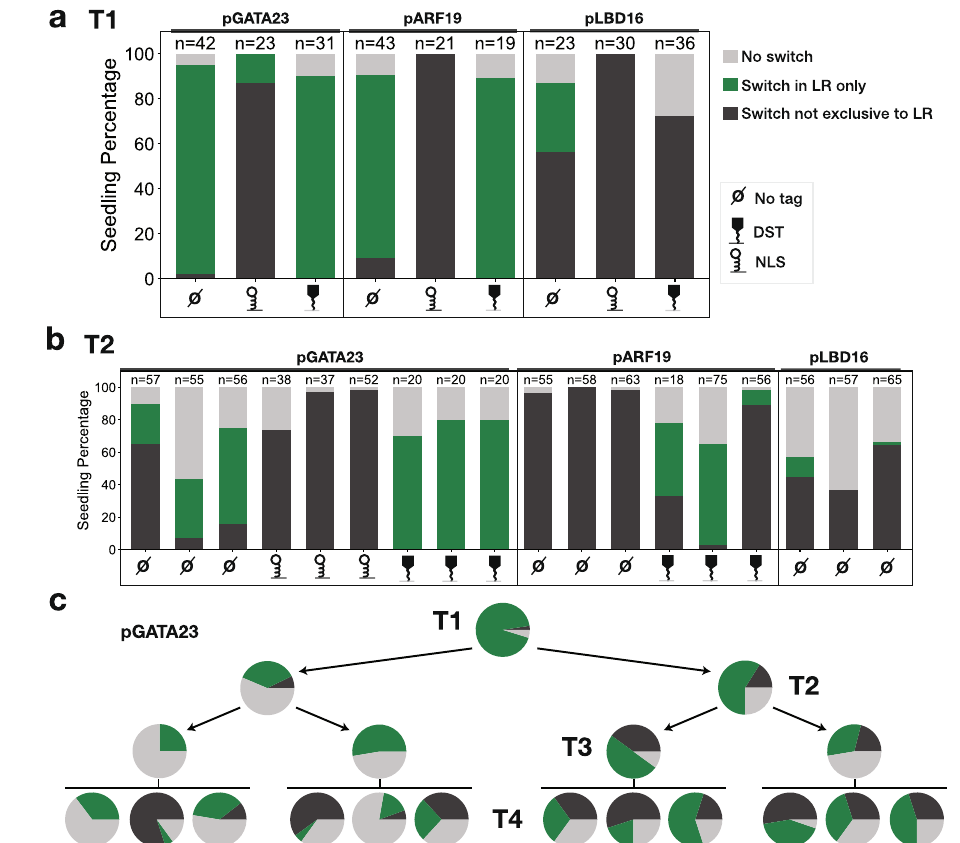
Fig. 4 | Developmental promoters with tuning tags are stable over multiple generations. a Phenotyping of T1 seedlings with constructs in PhiC31 target line, PhiC31 integrase is expressed from the indicated developmental promoters in combination with various tuning tags (legend on the right). The percentage of seedlings in each of the de fi ned phenotypic categories is shown. b Phenotyping of T2seedlingsfrom a subset of the T1linesrepresented in ( a ).T2from three T1lines